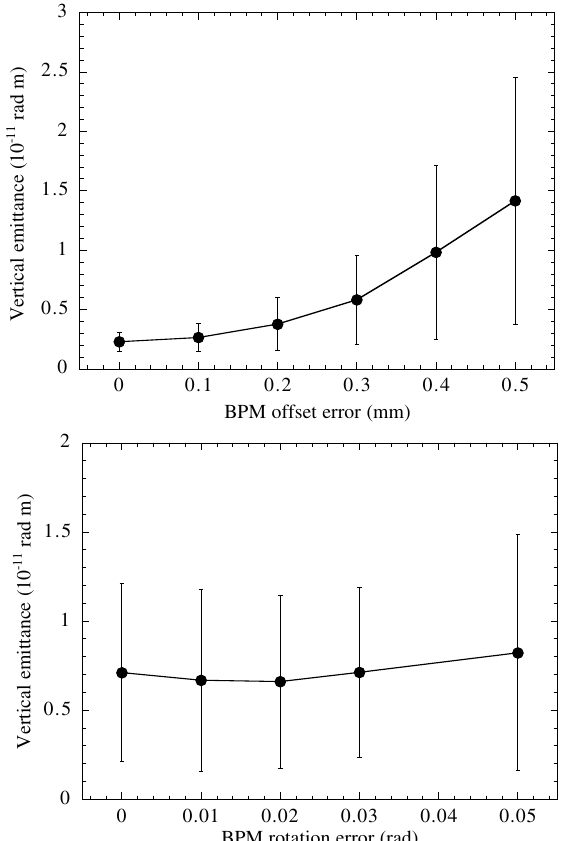
FIG. 10. Averages of (cid:26) and (bottom panel) BPM rotation error ( (cid:27) correction. Error bars indicate the standard